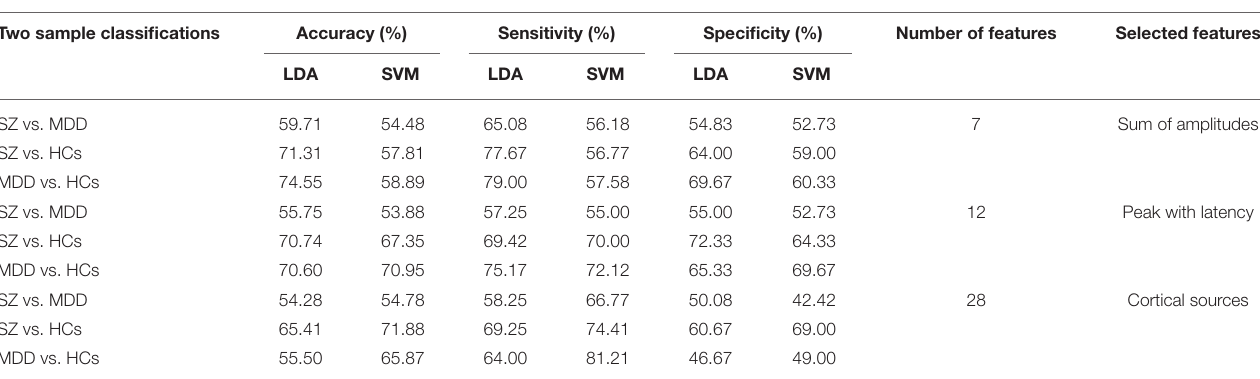
TABLE 3 | Classification using LDA and